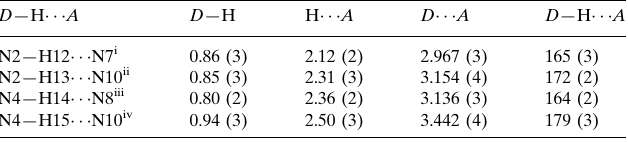
Hydrogen-bond geometry (A˚ , (cid:2)